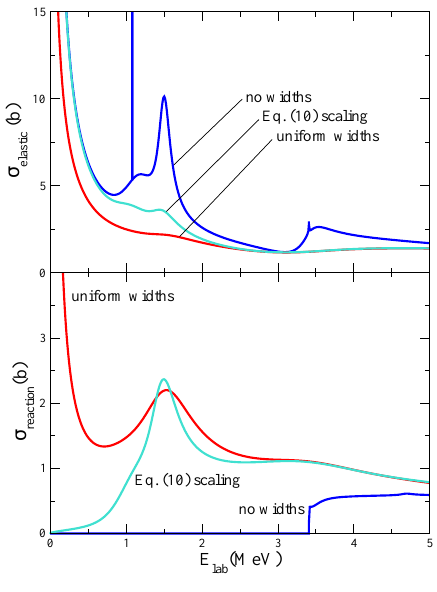
Figure 3. Upper: MCAS n + 8 Be elastic cross sections (upper panel) and reaction cross sections (lower panel) for Eq.